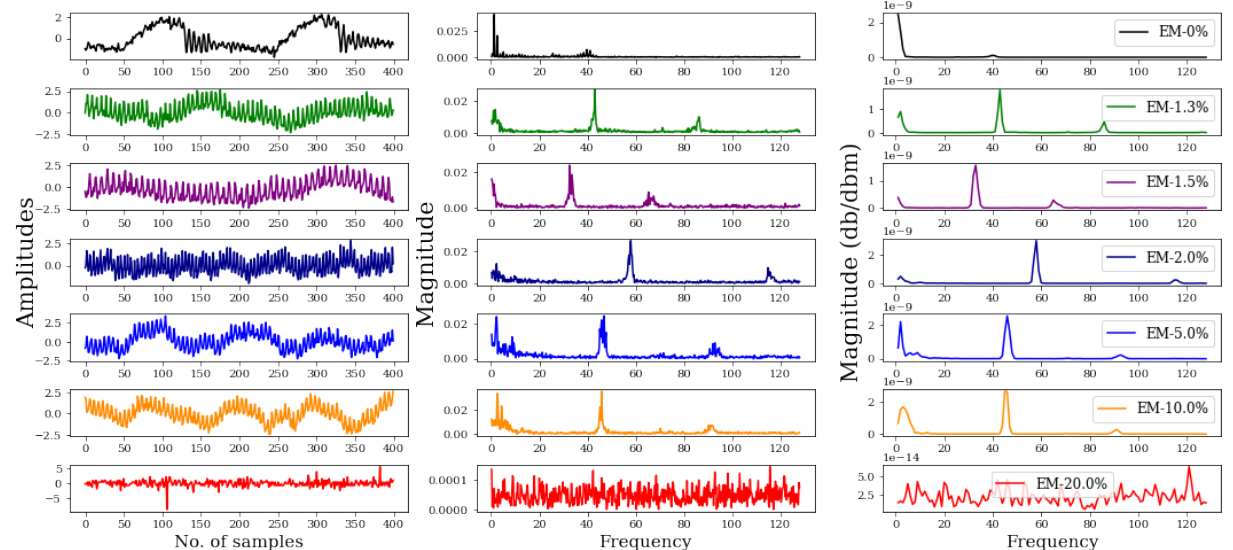
Figure A1. CR signals and their FFT and PSD outputs at 900 RPM for the emulsion compositions.